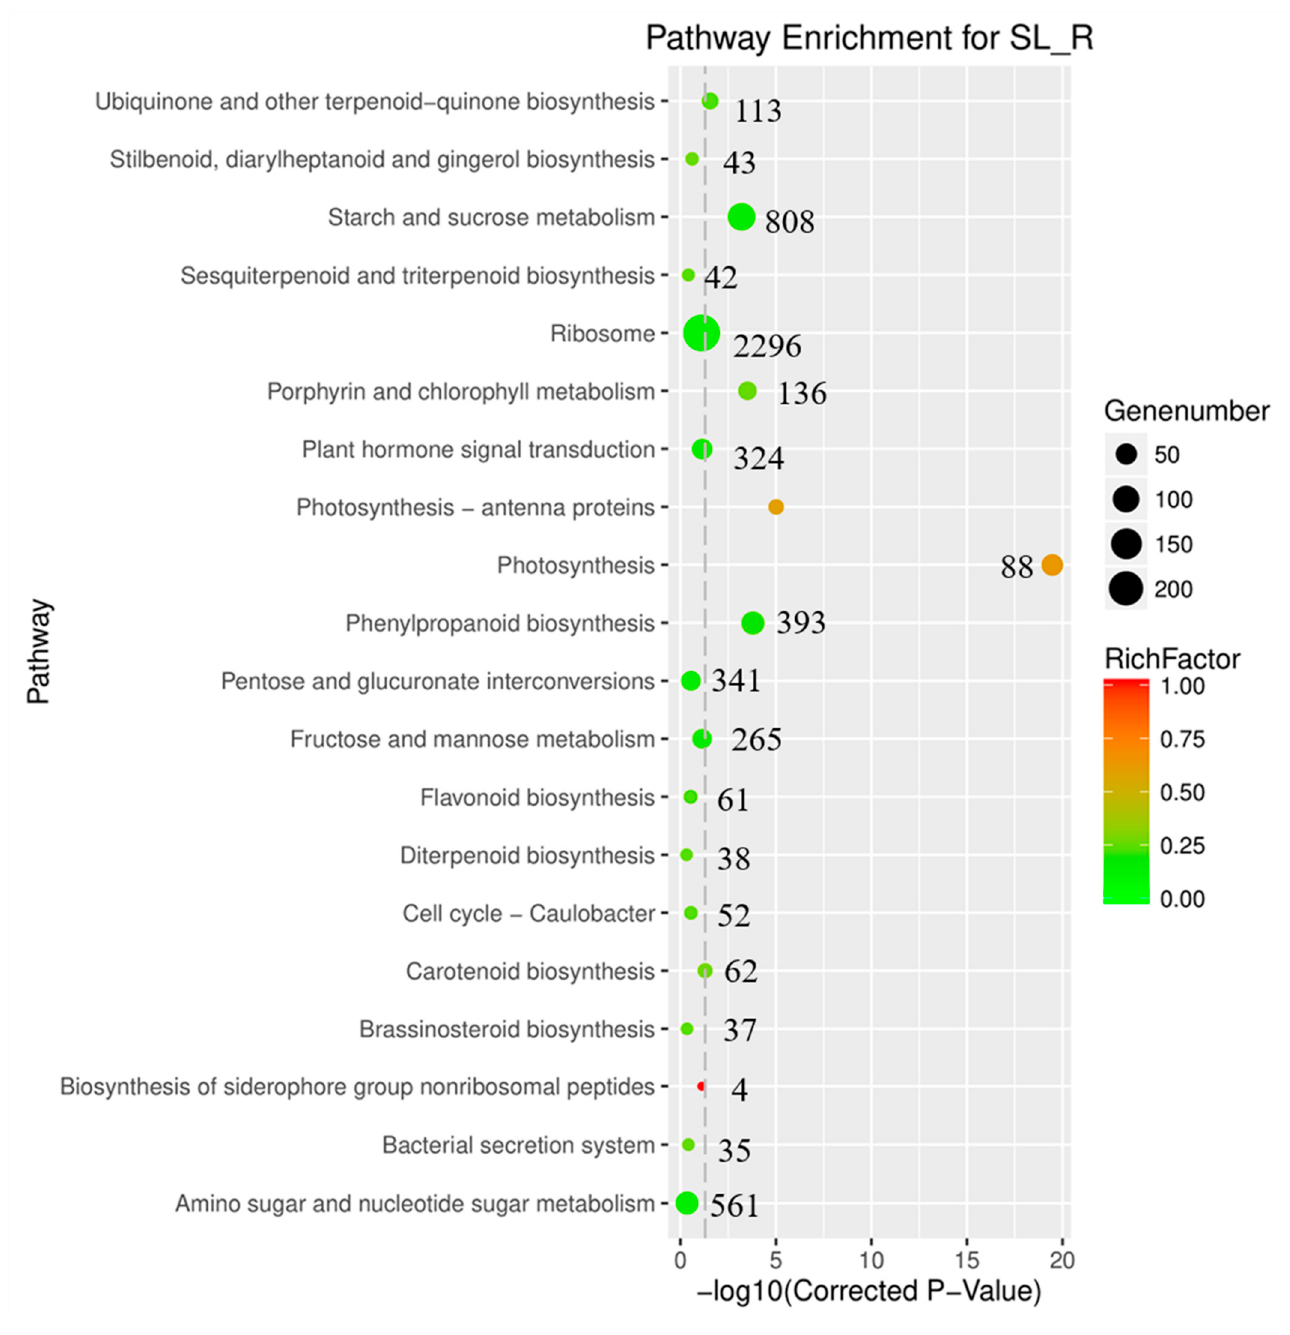
Figure 2. Statistics of DEGs enriched in the KEGG pathway between the samples of roots (R) and a mixture of stems and leaves (SL). Y-axis on the right side shows the number of differentially expressed genes.